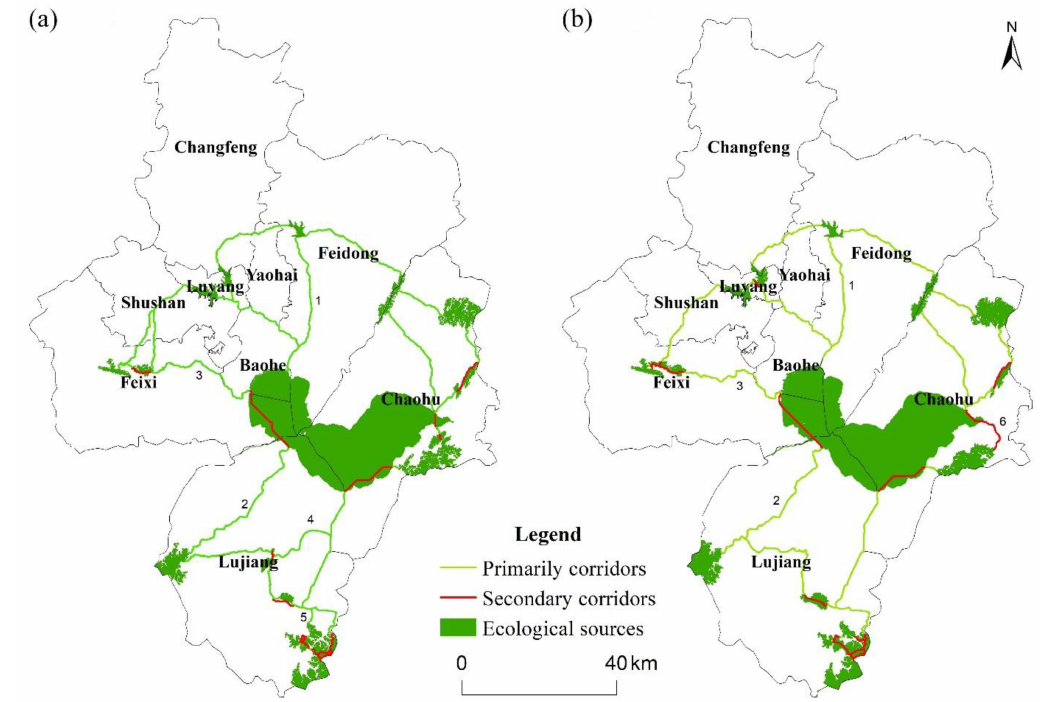
Figure 5. Ecological corridors of Hefei for ( a ) 2020, ( b )